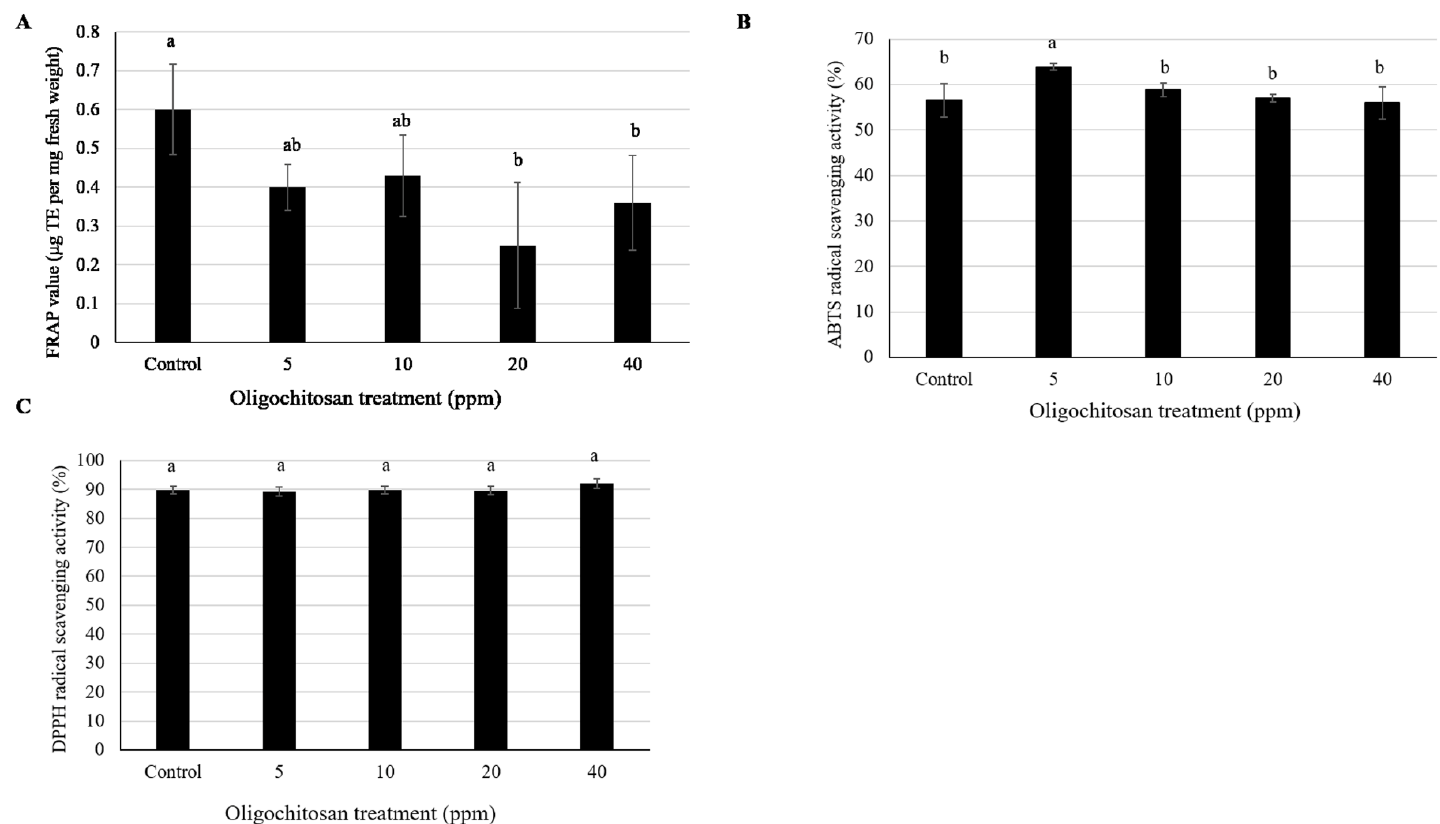
Figure 3. Antioxidant capacity in WRS exposed to oligochitosan O-80, as measured by the ( A ) Ferric ion reducing antioxidant (FRAP), ( B ) 2 (cid:48) -azino-bis (3-ethylbenzothiazoline-6-sulphonic acid (ABTS) and ( C ) 2,2-diphenyl-1-picrylhydrazyl (DPPH) assays. For each assay, bars with di ff erent letters above them were significantly di ff erent according to Duncan’s multiple range test ( p < 0.05). Control is O-80 at 0 ppm.